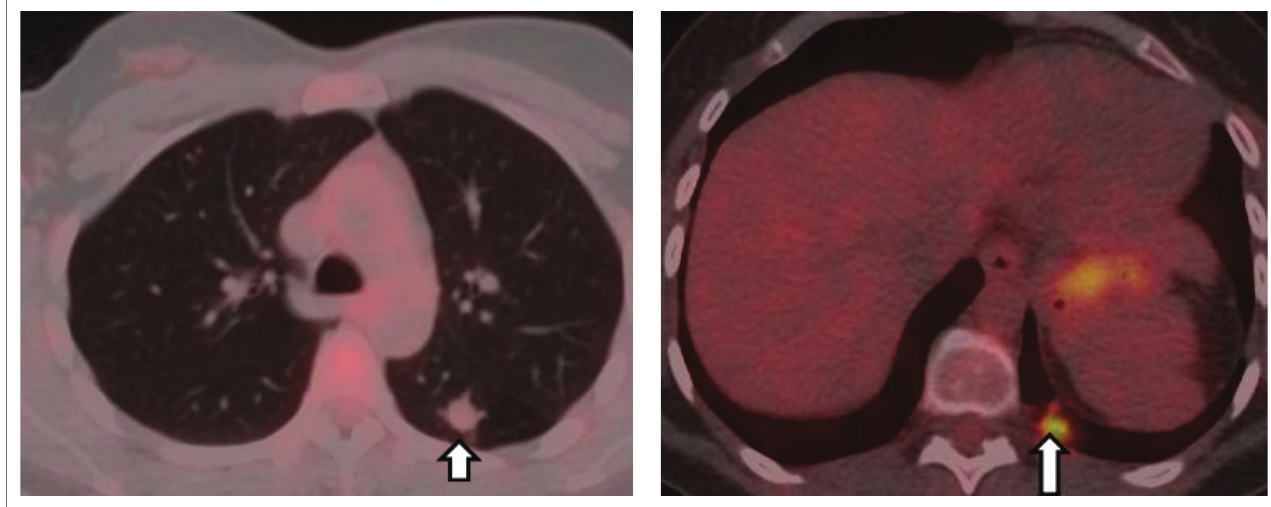
FIGURE 4: A 43-year-old with luminal disease with a left lung non-spiculated lesion suspicious of fluorodeoxyglucose positron emission tomography/computed tomography was subjected to a computed tomography – guided biopsy. SUVmax primary breast tumour = 16.4, suspected lung lesion 4.8. Biopsy results were negative for